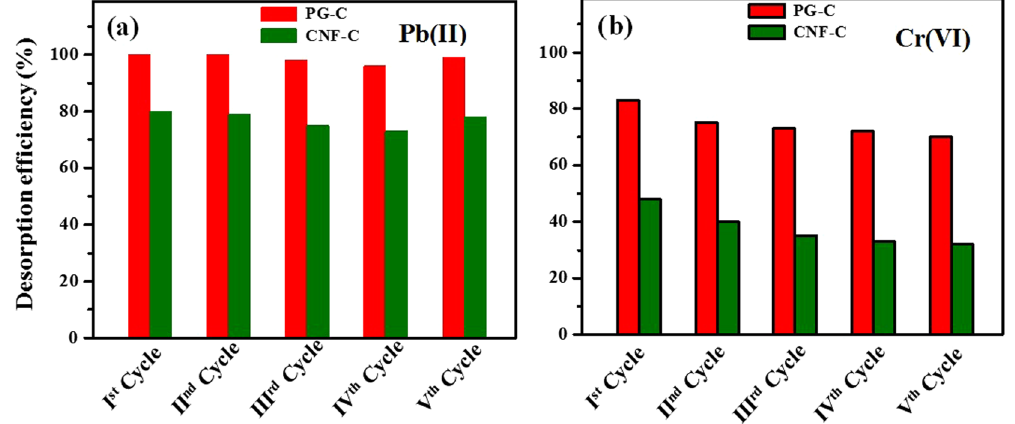
Figure 8. Desorption studies of synthesized nanocomposites for ( a ) Pb(II) and ( b ) Cr(VI)